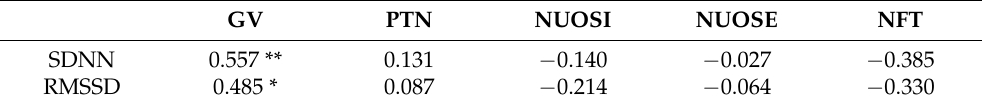
Table 3. Pearson correlation between heart rate variability of landscape amenity